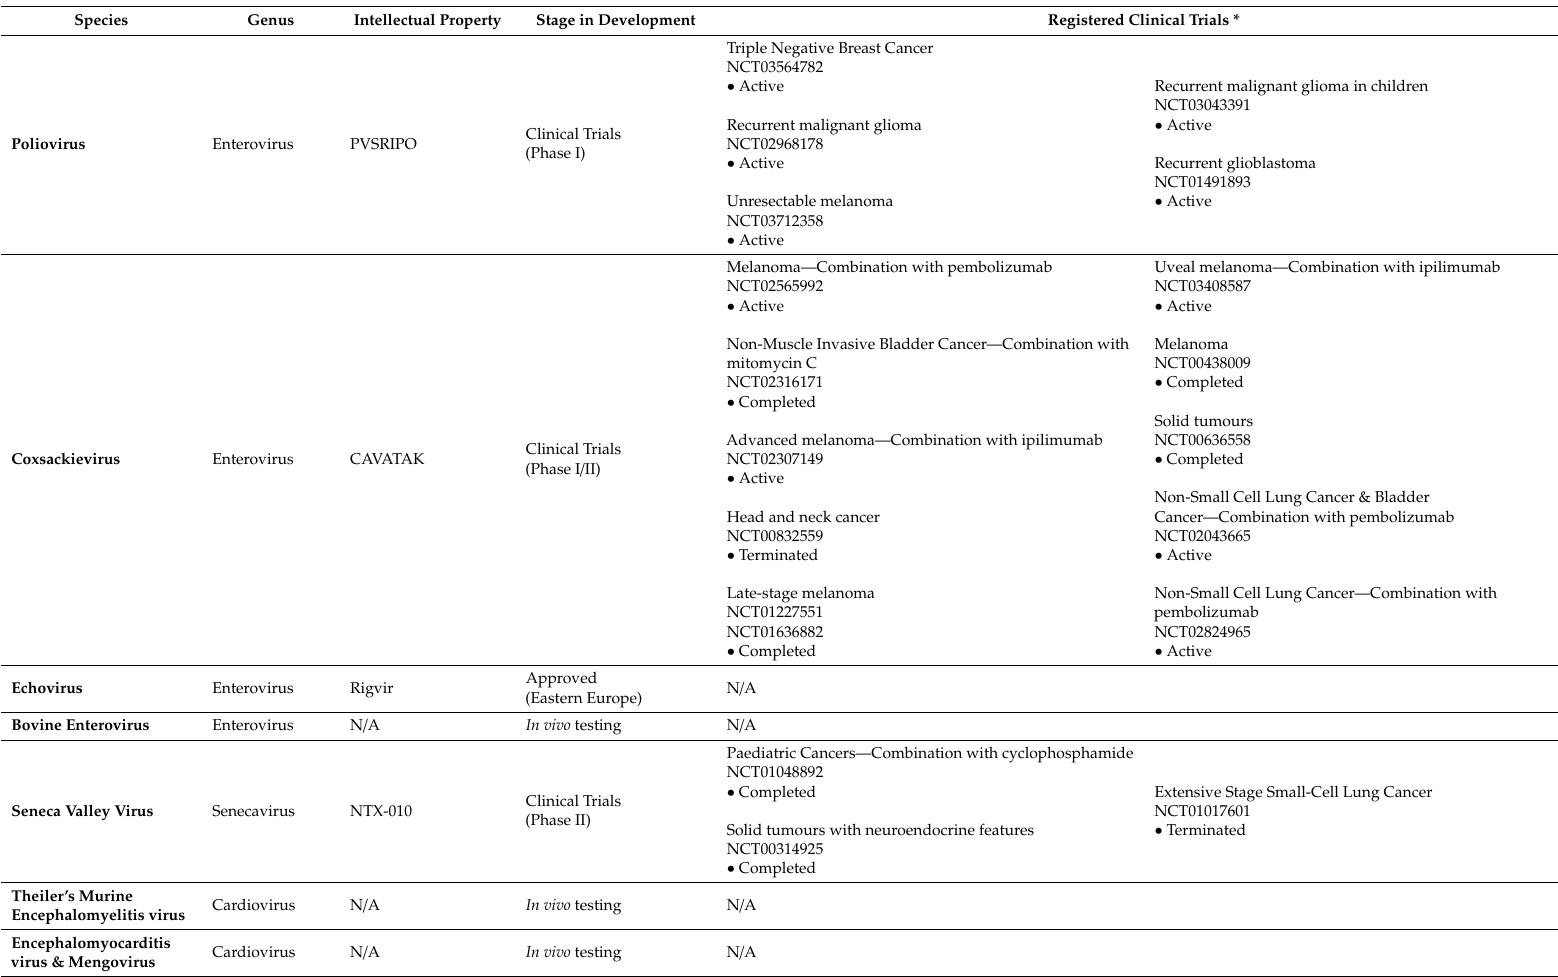
Table 3. Summary of the clinical development of the picornavirus species discussed in this